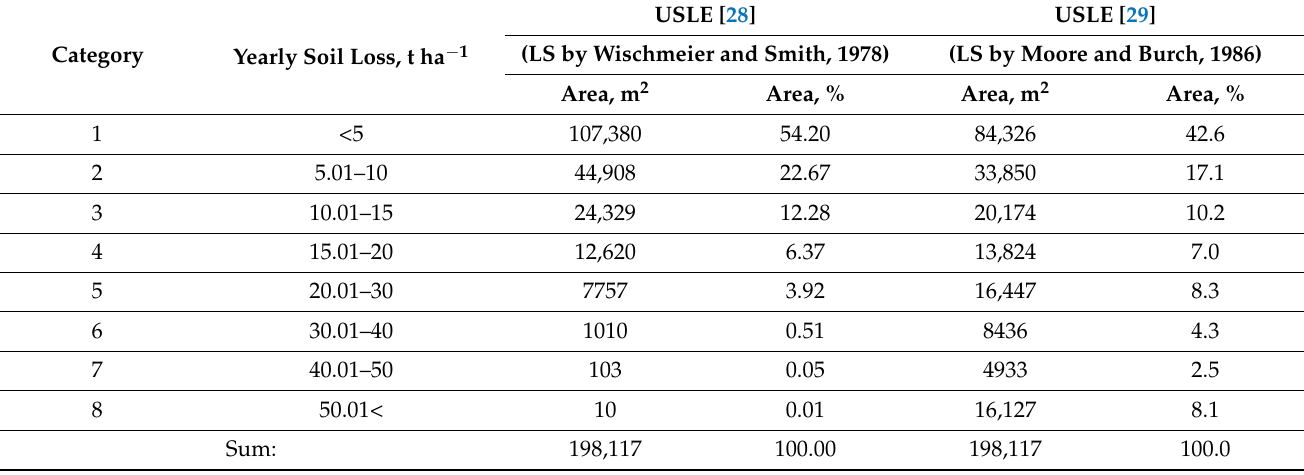
Figure 8. Potential yearly soil loss, determined by the modified USLE (RUSLE) equation, and targeted points 1 and 2 for in situ measurements. Table 2. Estimated soil loss in the experimental field.